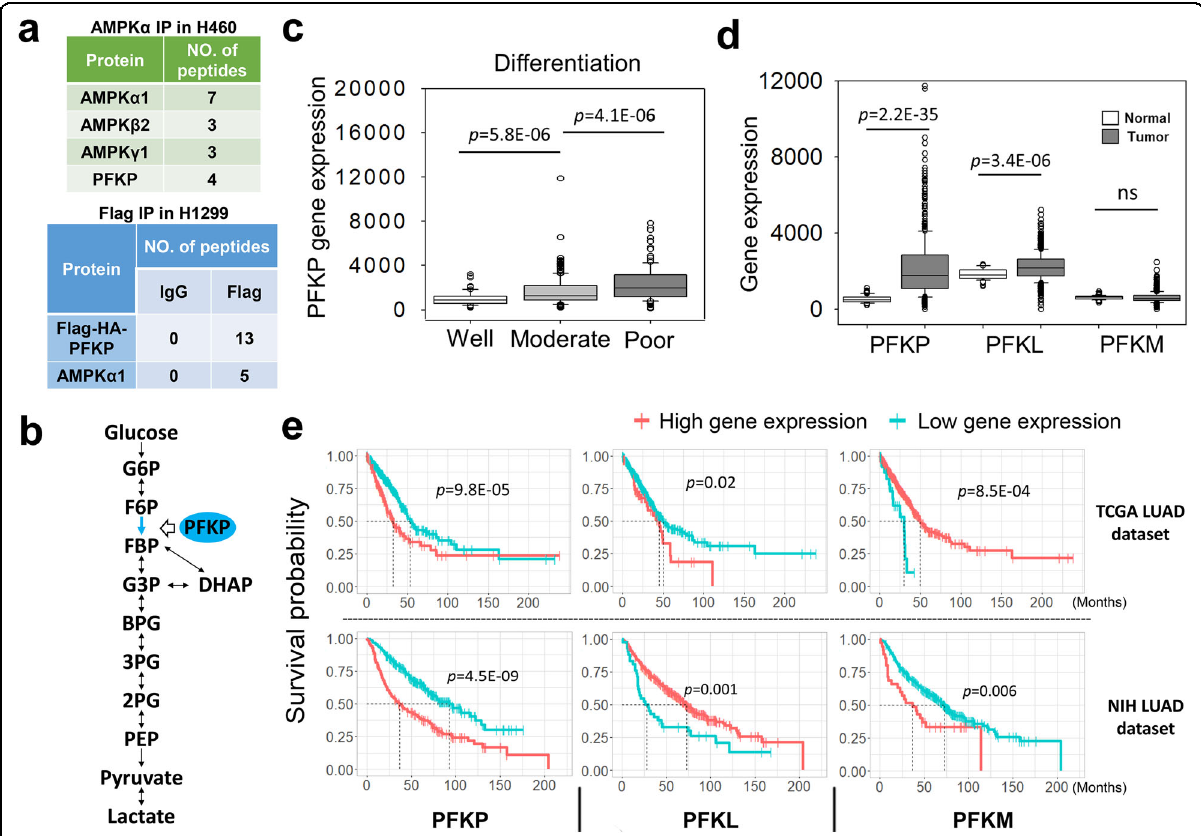
Fig. 1 PFKP is an AMPK-interacting protein and highly expressed in lung adenocarcinoma. a Mass spectrometry analysis of interacting proteins using AMPK α or Flag-HA-PFKP as bait in NSCLC cells under GS for 4 h. b Diagram of glycolysis pathway and the step catalyzed by PFKP. G6P Glucose- 6-Phosphate, F6P Fructose-6-Phosphate, FBP Fructose-1,6-bisphosphate, G3P Glyceraldehyde-3-Phosphate, DHAP Dihydroxyacetone-Phosphate, BPG 1,3-Bisphosphoglycerate, 3PG 3-Phosphoglycerate, 2PG 2-Phosphoglycerate, PEP Phosphoenolpyruvate. c Gene expression levels of PFKP in well, moderately, and poorly differentiated tumors from the NIH LUAD dataset. d Gene expression levels of PFKP , PFKL , and PFKM in tumor and adjacent normal tissue from the TCGA LUAD dataset. e Survival analysis of lung adenocarcinoma patients with high or low expression of PFKP , PFKL , and PFKM in the TCGA LUAD dataset ( n = 501) and NIH LUAD dataset ( n = 442). Data are shown as means ± SD with n indicating the number of patients in the datasets. P values by Mann – Whitney U